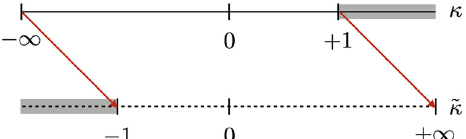
Fig. 3 Schematic representation of the Möbius transformation ˜ κ = κ/( 1 − κ) , illustrating that the κ = 1 vacuum is mapped to positive infinity in the ρ frame. The abyssal region (grey shading) is mapped from right to left, placing it behind the infinite barrier at ˜ κ = − 1 (see Figs. 1,